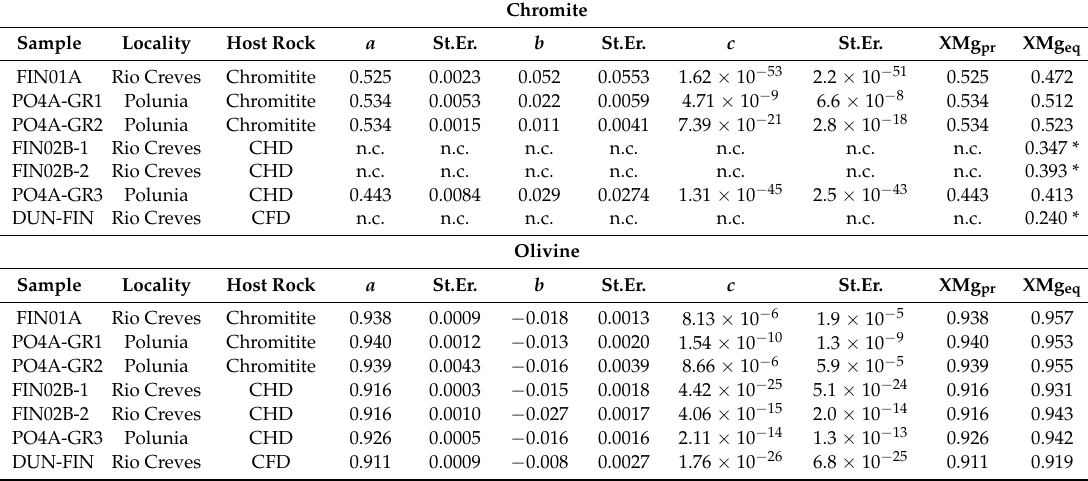
Table 3. Parameters a , b , c and associated standard error of calculated curves and primary (pr) and re-equilibrated (eq) XMg atomic ratios of chromites and olivines for three host rocks.